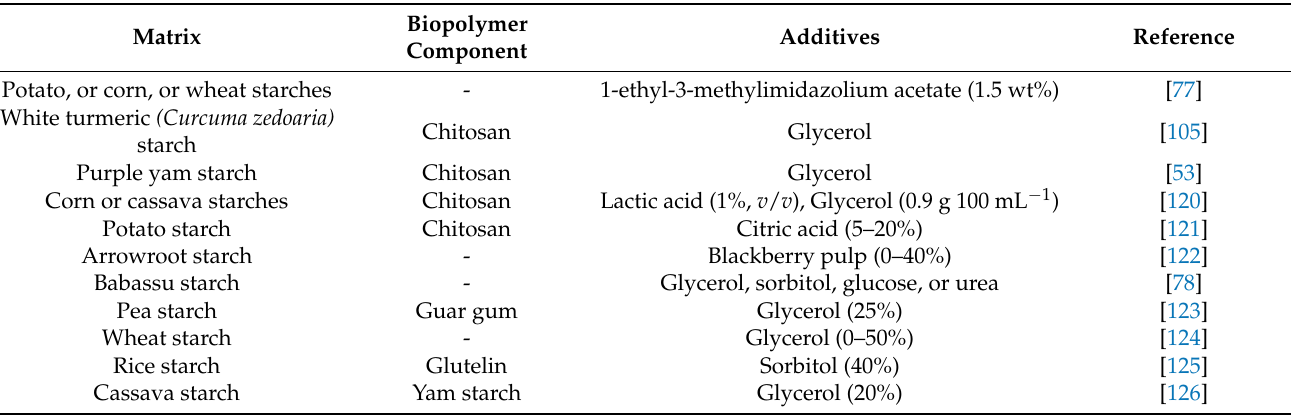
Table 3. Some starch-based films and